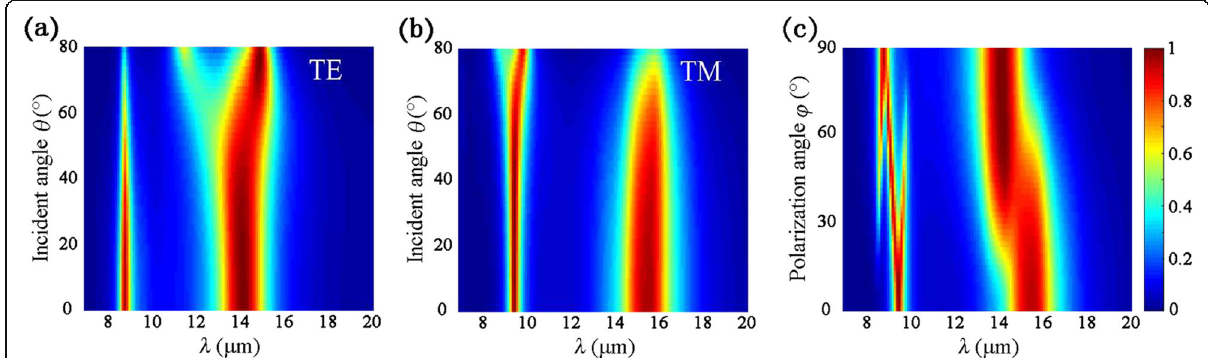
Fig. 5 Absorption spectra under various incident angles for a TE and b TM polarization and c various polarization angles under normal incidence. Geometric parameters are the same as in Fig.